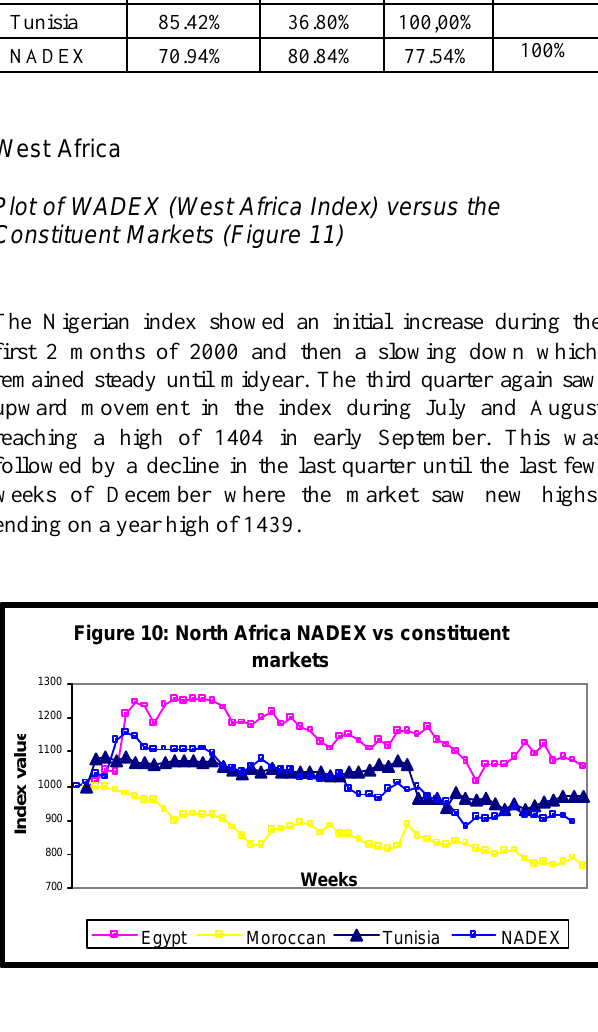
Table 3: Correlation analysis of North African indices and NADEX